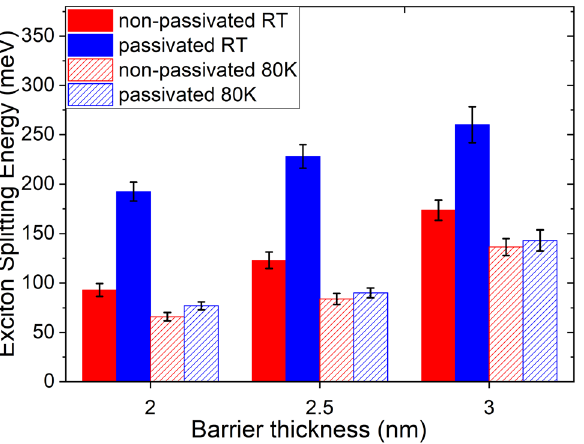
Figure 9. Calculated exciton splitting energies for NCs as a function of inter-layer-oxide barrier